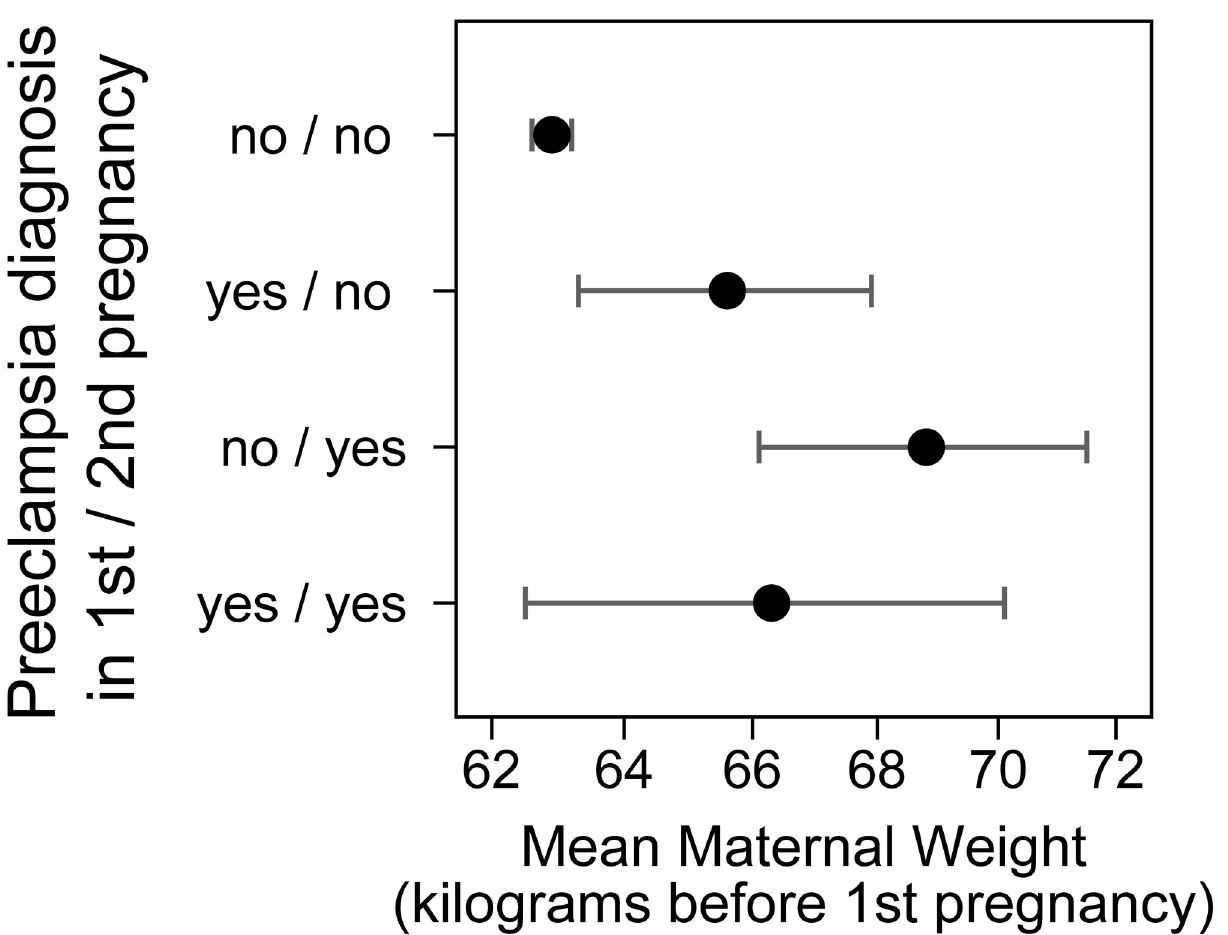
Figure 3. Mean of mother’s body weight before the first pregnancy for women with two recorded pregnancies depending on whether each pregnancy was affected by